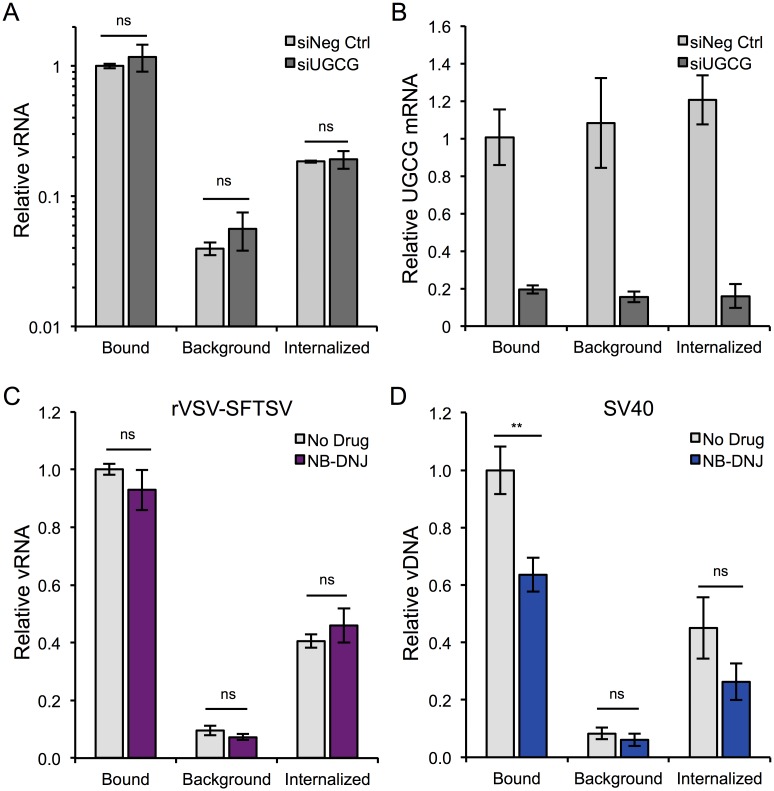
Mechanistic studies on UGCG’s role in SFTSV entry.(A) Binding and Internalization Assay. U-2 OS cells were transfected with negative control or UGCG siRNAs, replated the following day into 24 wells dishes, and the assay was performed 72 hours post-transfection. Assay details provided in Materials and Methods. vRNA levels were normalized to GAPDH mRNA levels, and are expressed relative to bound vRNA for the negative control siRNA. Mean ± S.E.M. for 3 independent experiments. (B) RNA collected from (A) was also analyzed for UGCG mRNA expression. UGCG mRNA levels were measured by RT-qPCR, normalized to GAPDH mRNA levels, and expressed relative to the negative control siRNA (bound). (C,D) The binding and internalization assay was carried out essentially as in (A) with the exception that U-2 OS cells were instead pre-treated with NB-DNJ for 48 hours prior to binding with rVSV-SFTSV (C) or SV40 (D) and qPCR for SV40 genomes did not require reverse transcription. Mean ± S.E.M. for 3 independent experiments. ** p<0.01 using Student’s t-test.